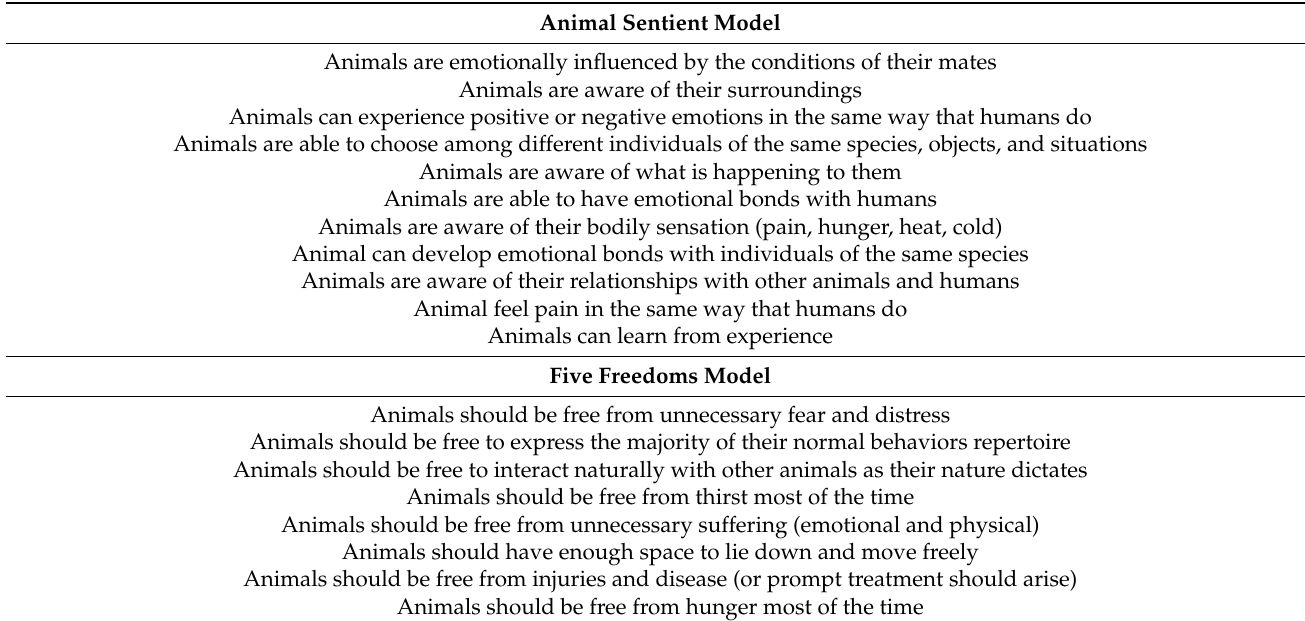
Table 1. List of items for Five Freedoms and animal Sentient models used in the scale. Animal Sentient Model